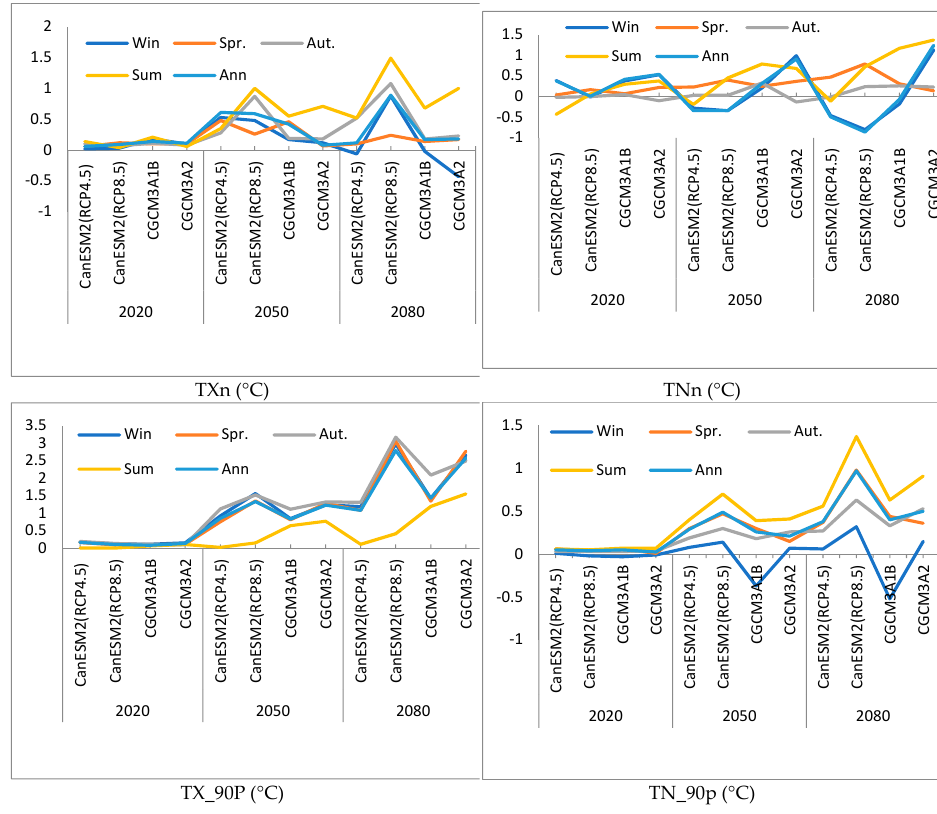
Figure 6. Changes in selected temperature extreme indices.